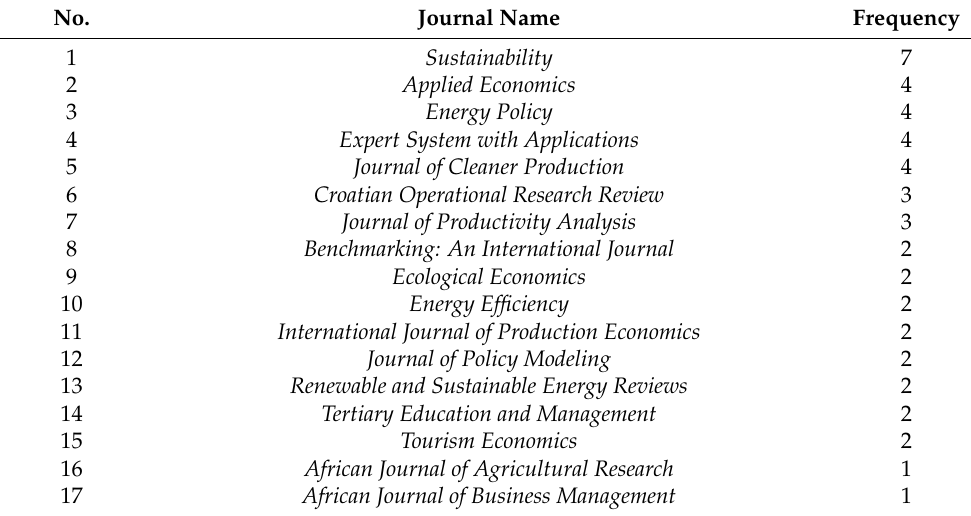
Table 1. List of journals publishing DEA window analysis articles.